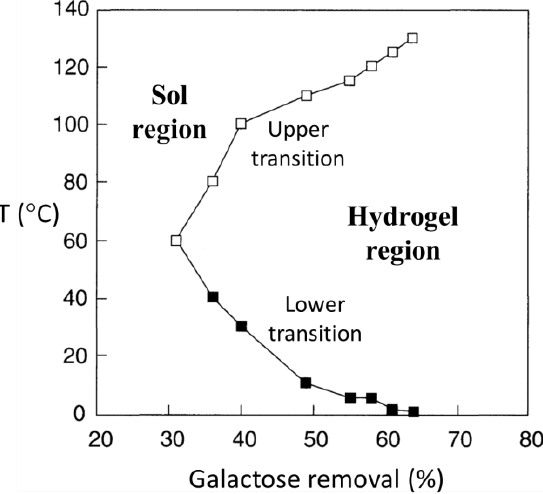
Figure 5. Temperature of the sol–gel transition of degalactosylated XG. Filled squares and empty squares indicate the lower and the upper transition temperatures, respectively. (Reproduced from Reference [32], with permission from Trends in Glycoscience and Glycotechnology.)